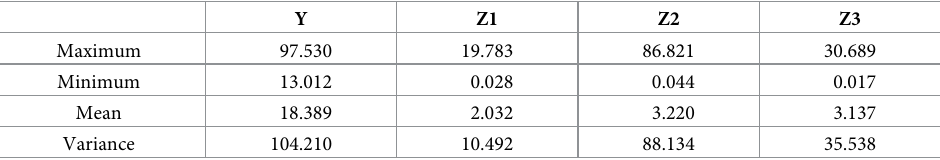
Table 1. Statistics of output Y and terms Z i (dataset